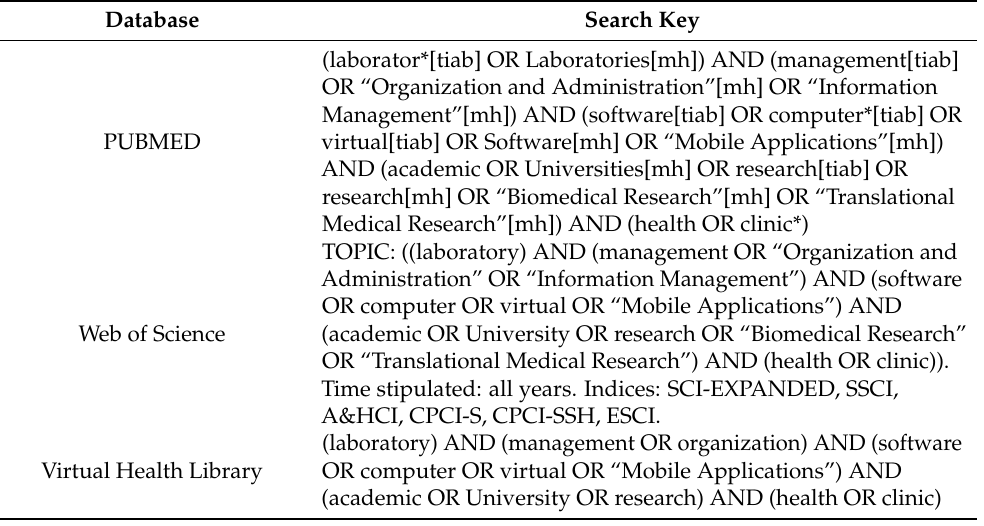
Table 1. Search keys applied to the three consulted